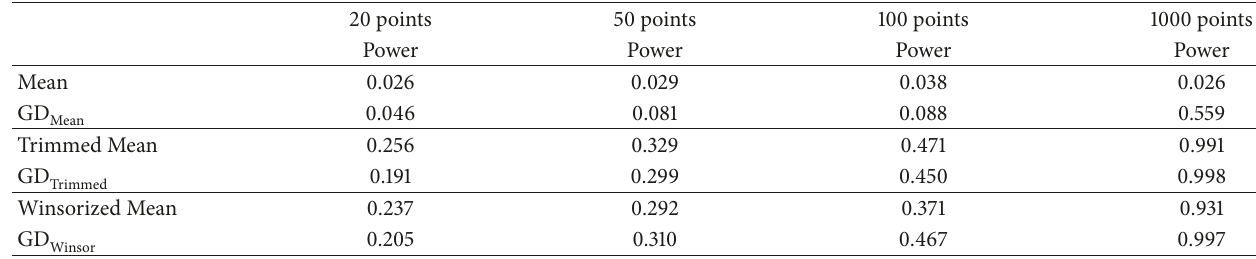
Table 37: Exponential distributions with 50% noise level.